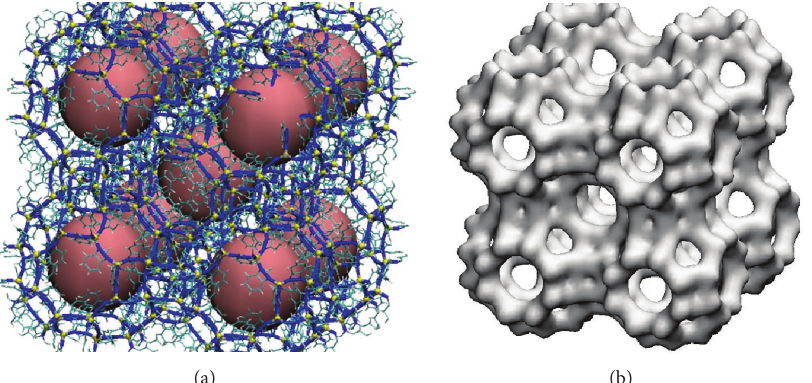
Figure 3: The ZIF-11 framework used as the simulations cell; (a) and (b) are both side views that represent the full caves (big grey balls) within the